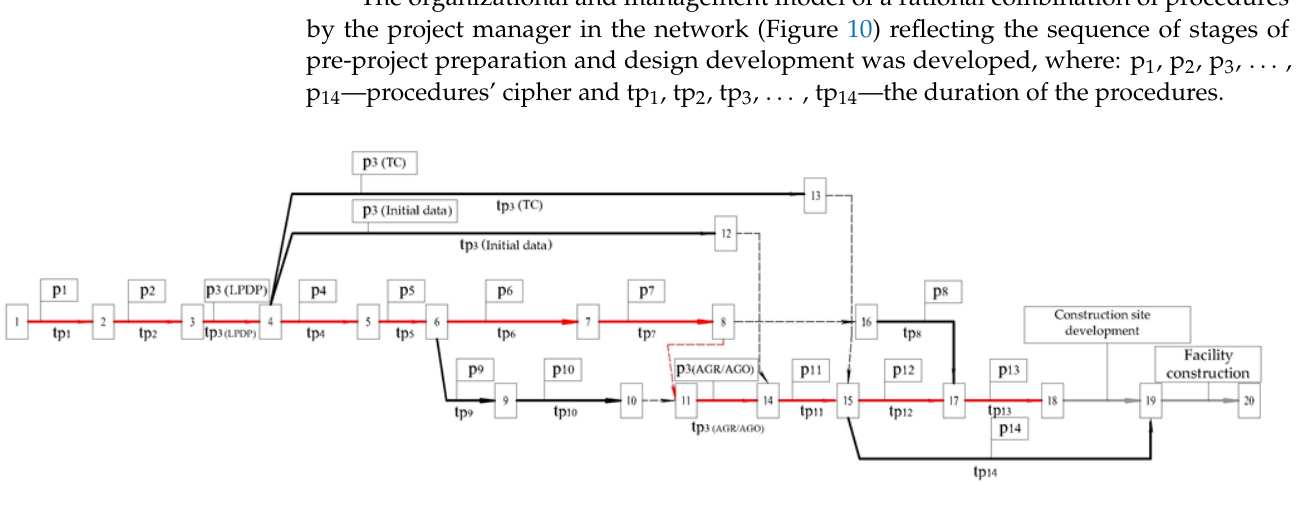
Figure 10. Organizational and management model of the rational combination of procedures at the stages of pre-project preparation and design development in the network form.